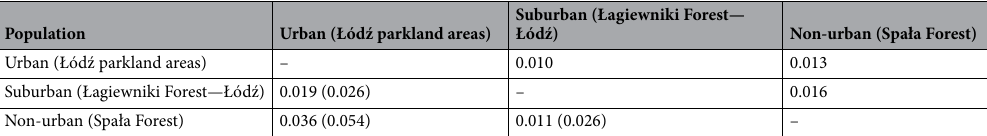
Table 6. Matrix of Nei’s unbiased genetic distance for all ten microsatellite loci between selected populations of the great tits (below diagonal) and the blue tits (above diagonal). For great tits, values estimated under reduced sample size (uniform with blue tit) are shown in parentheses. Urban, suburban and non-urban populations are represented by individuals sampled in Łódź parkland areas, Łagiewniki Forest, and Spała Forest, respectively.